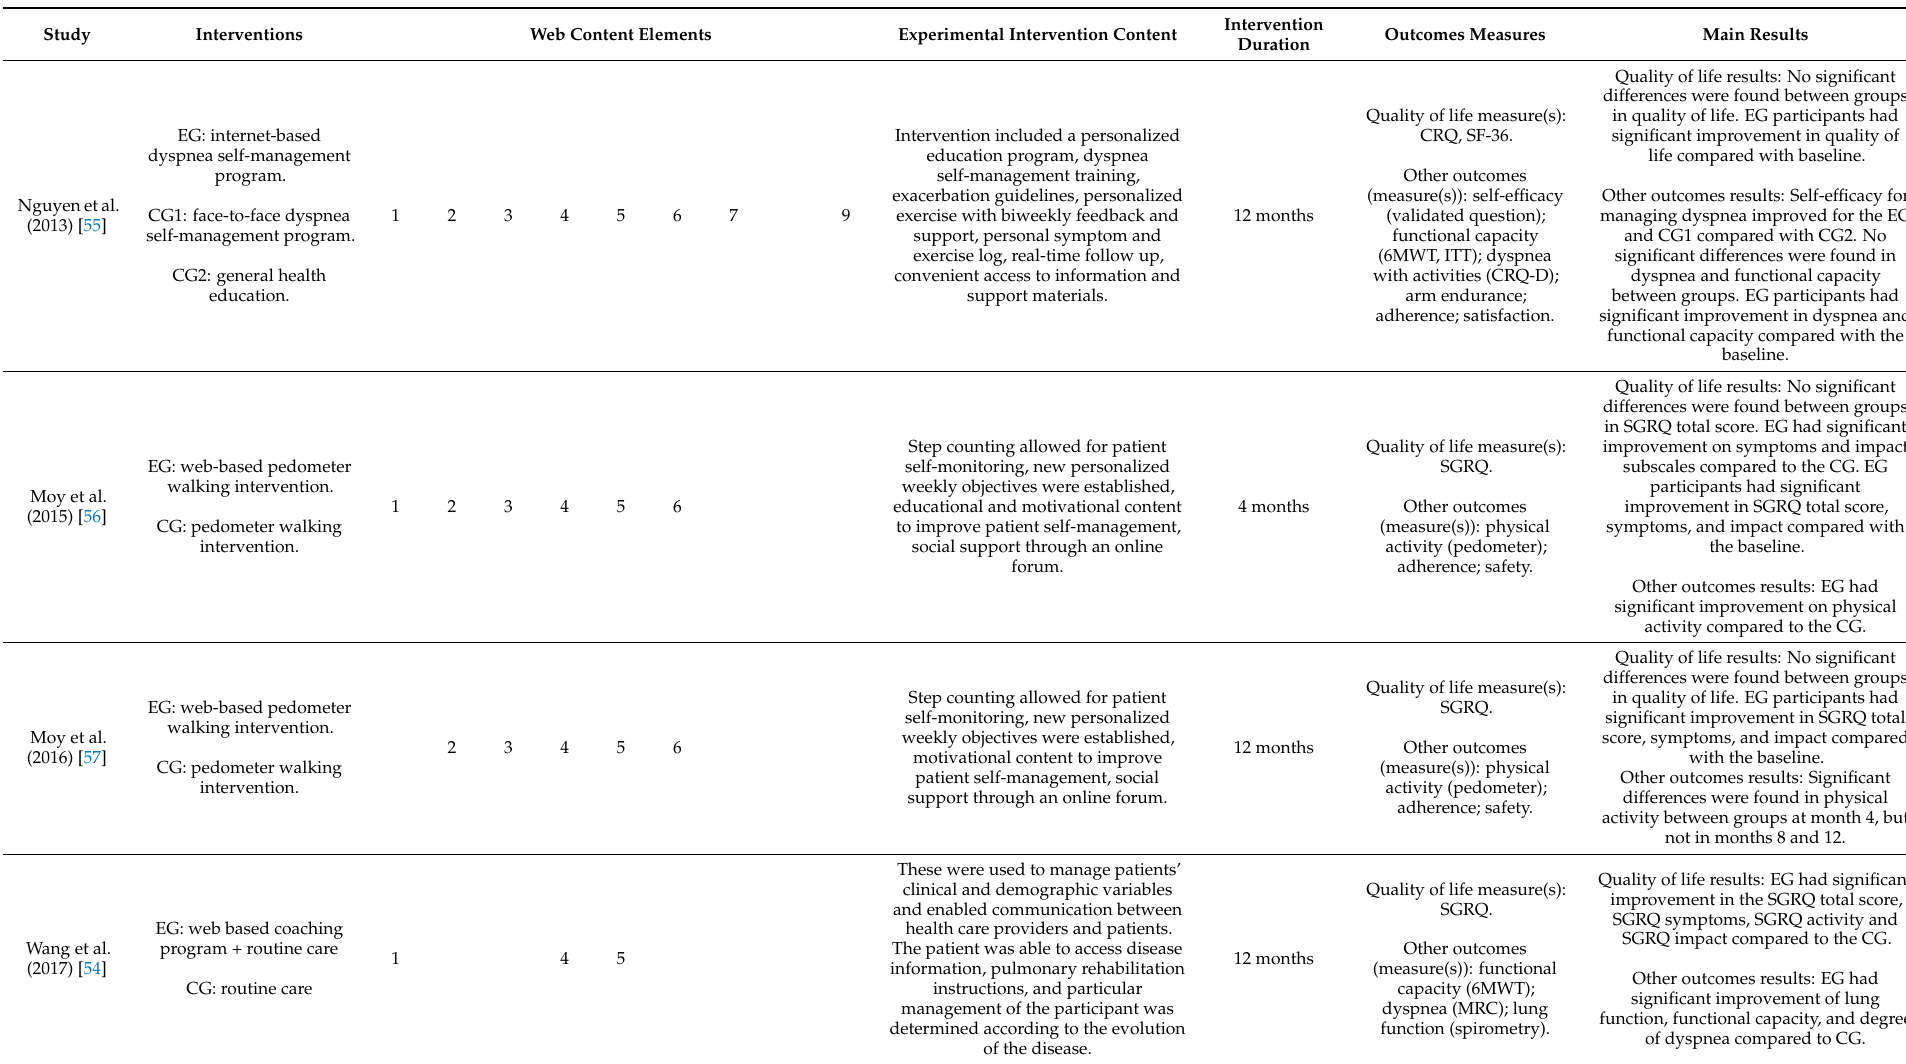
Table 2. Characteristics of the included studies in this systematic